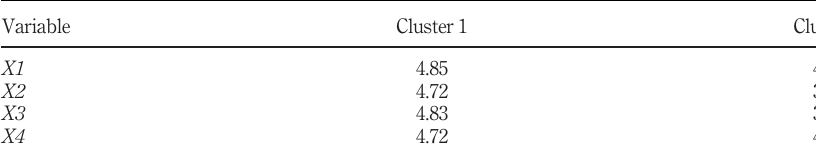
Table 2. The centroid of